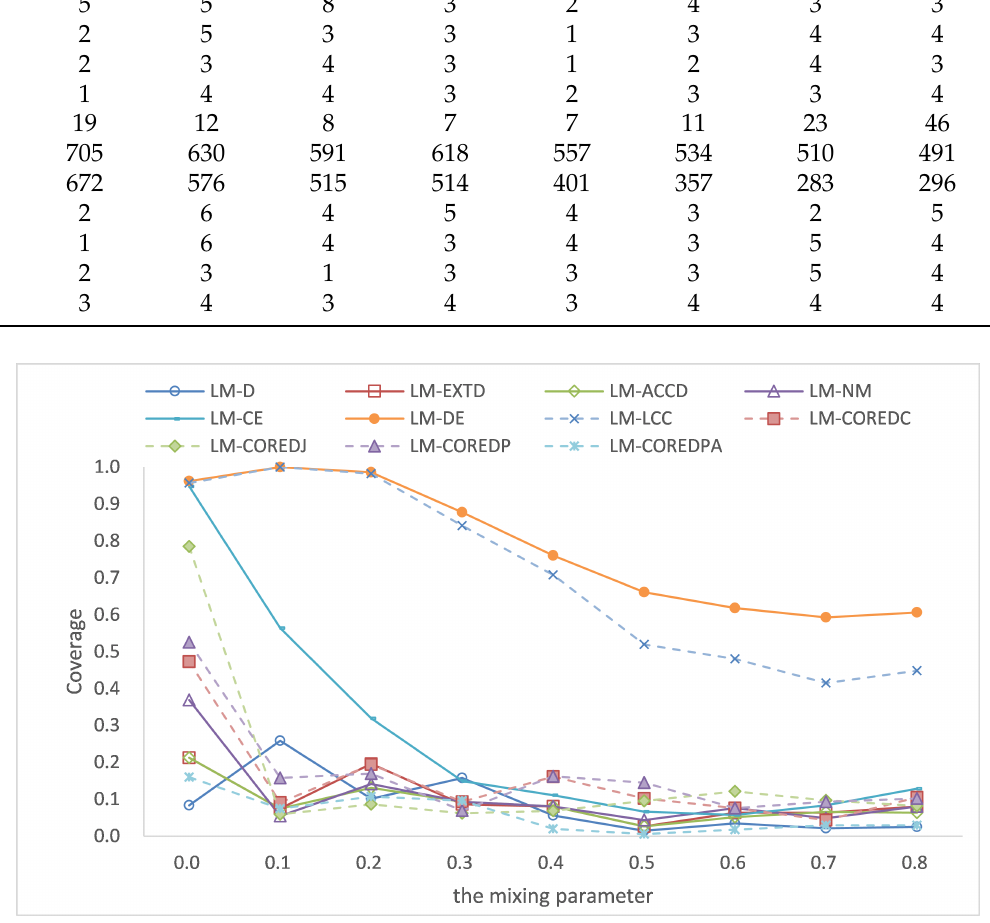
Figure 6. The coverage obtained by different local seeding algorithms over different